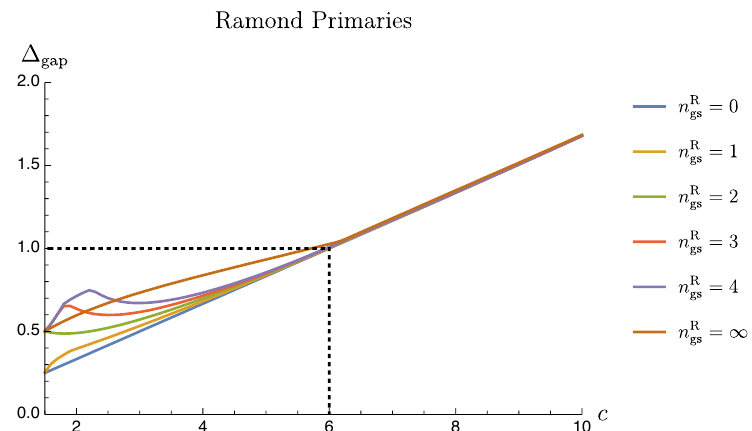
Figure 9: Upper bounds on the gap in the Ramond primary spectrum, for varying number of ground states n R central charge is varied up to c =